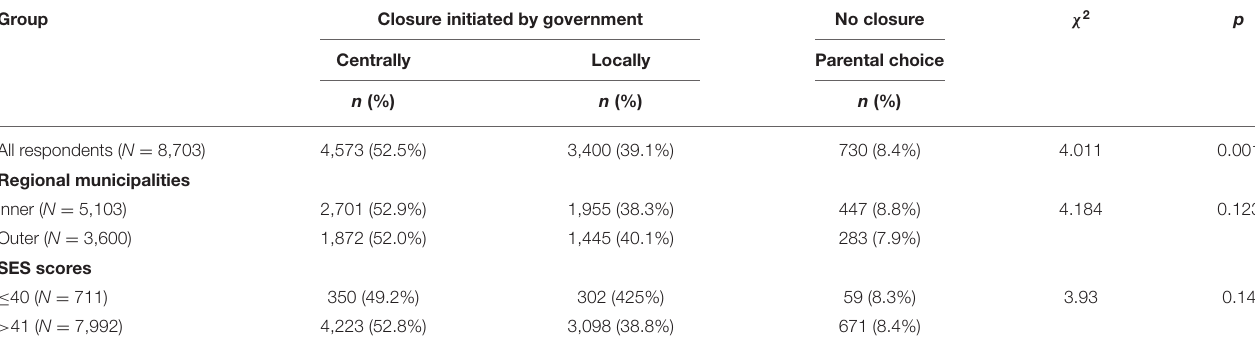
TABLE 2 | Responses to the SOSC-COVID-19 survey about initiating school closures by group: all respondents, regional municipalities, and SES scores above or below 40. Group Closure initiated by